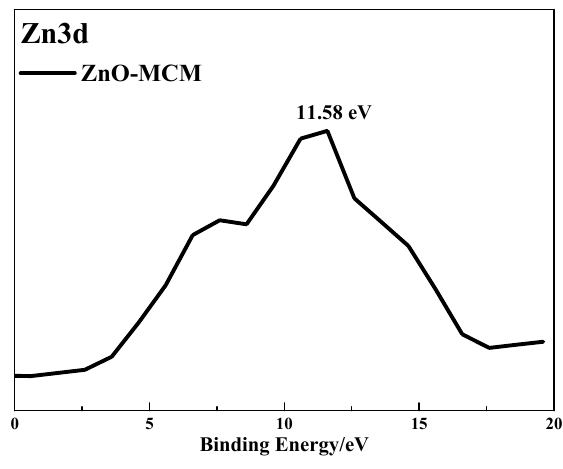
Figure 7. XPS of Zn 3d of ZnO-MCM.